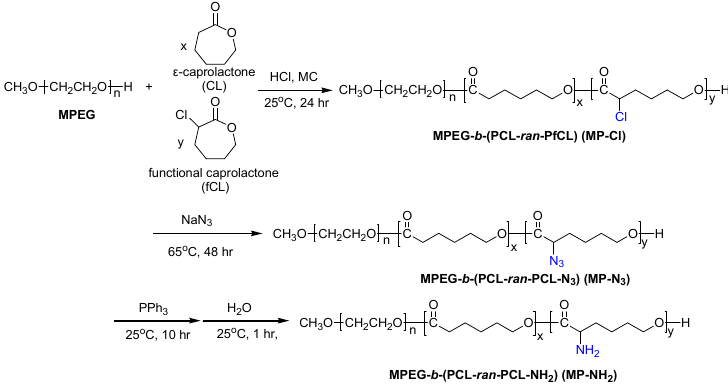
Figure 1. Synthesis of MP-Cl, MP-N 3 and MP-NH 2 diblock copolymers.